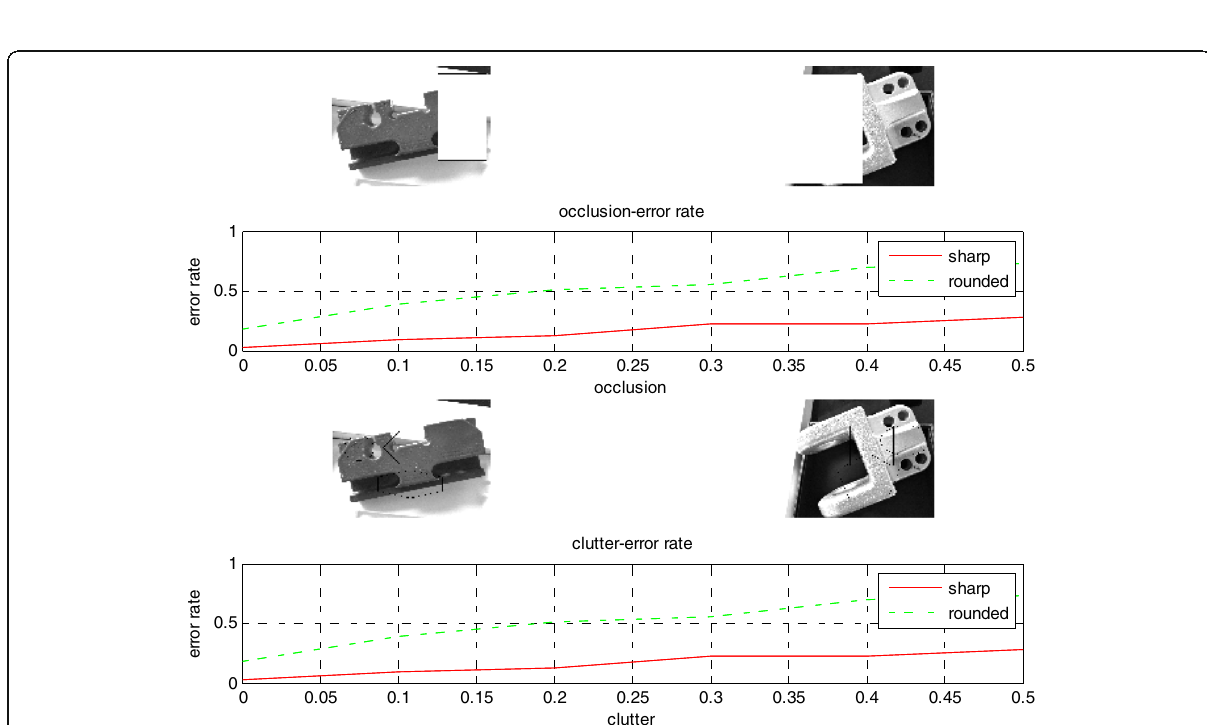
Fig. 9 Error rates about occlusion and